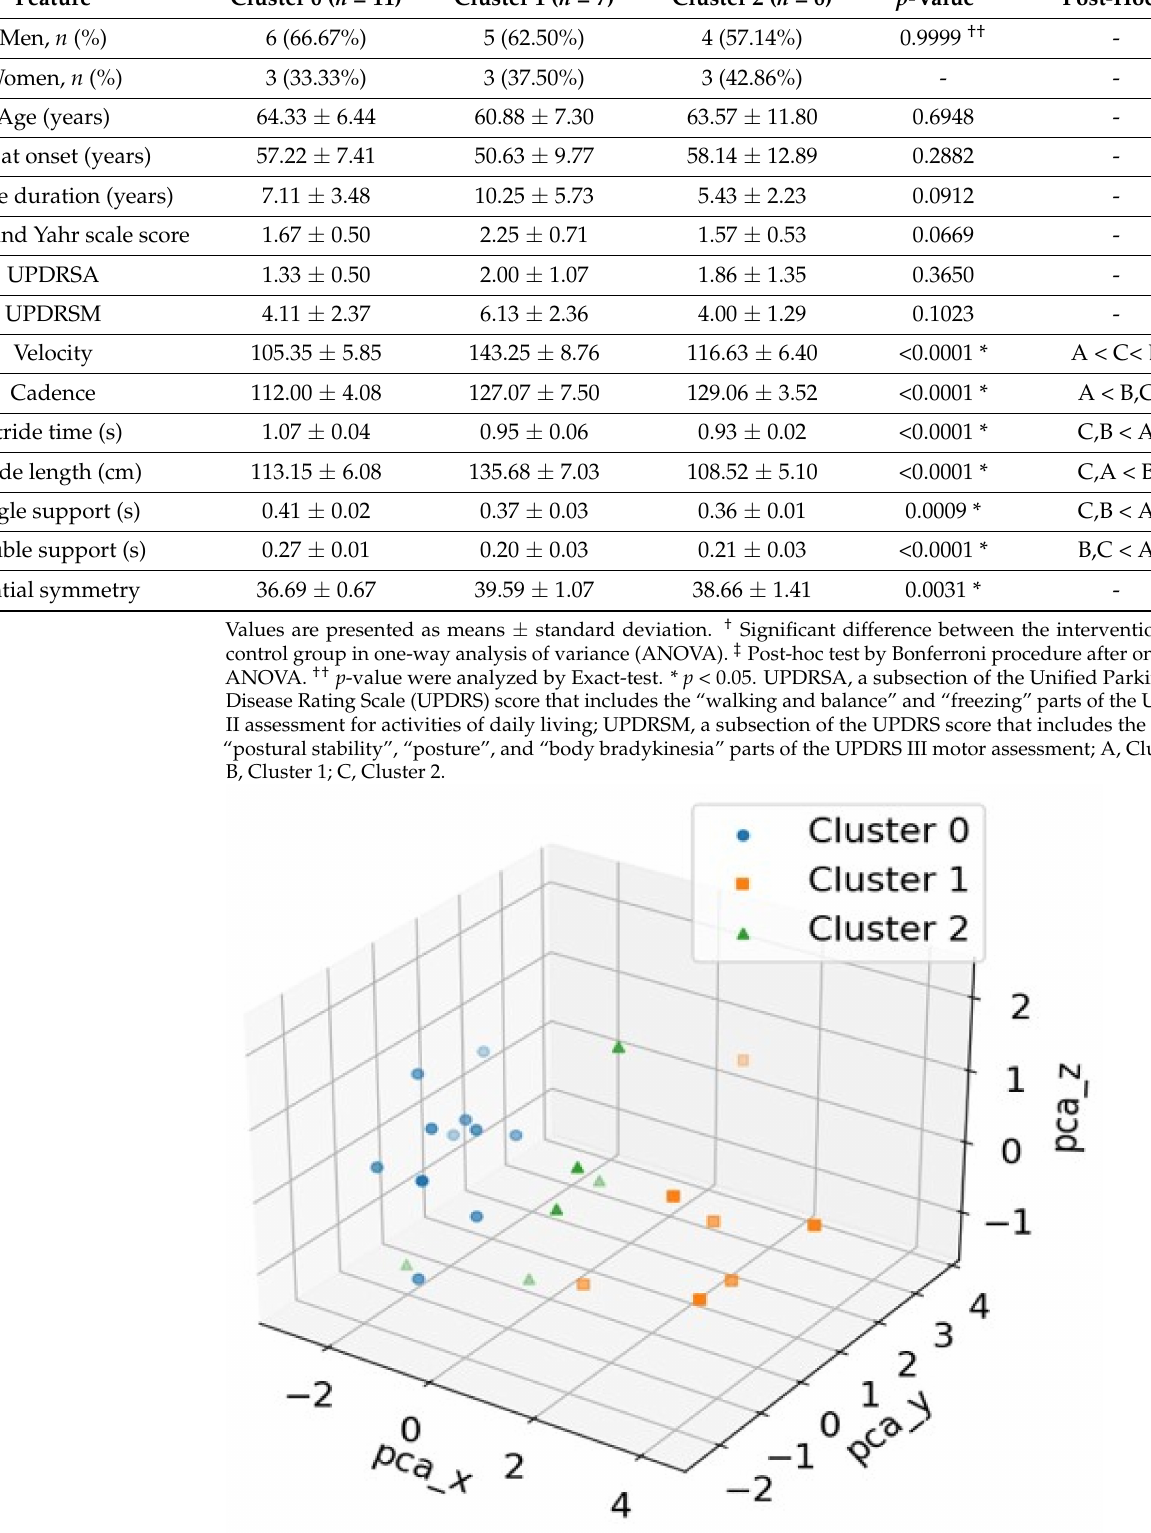
Figure 2. Three-dimensional scatter plot of the principal component analysis (PCA) to distinguish the three